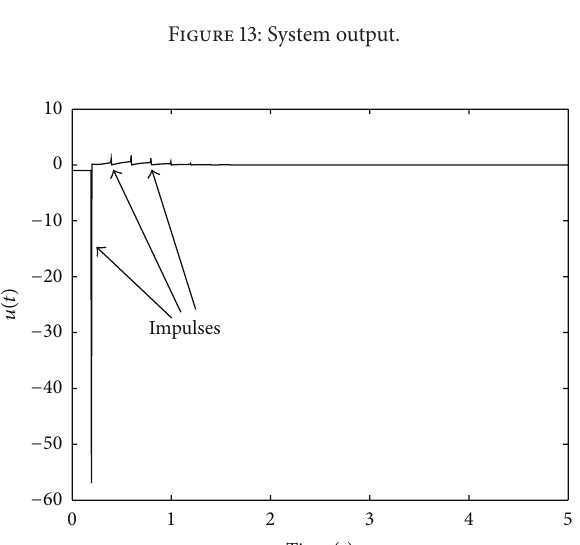
Figure 13: System output.